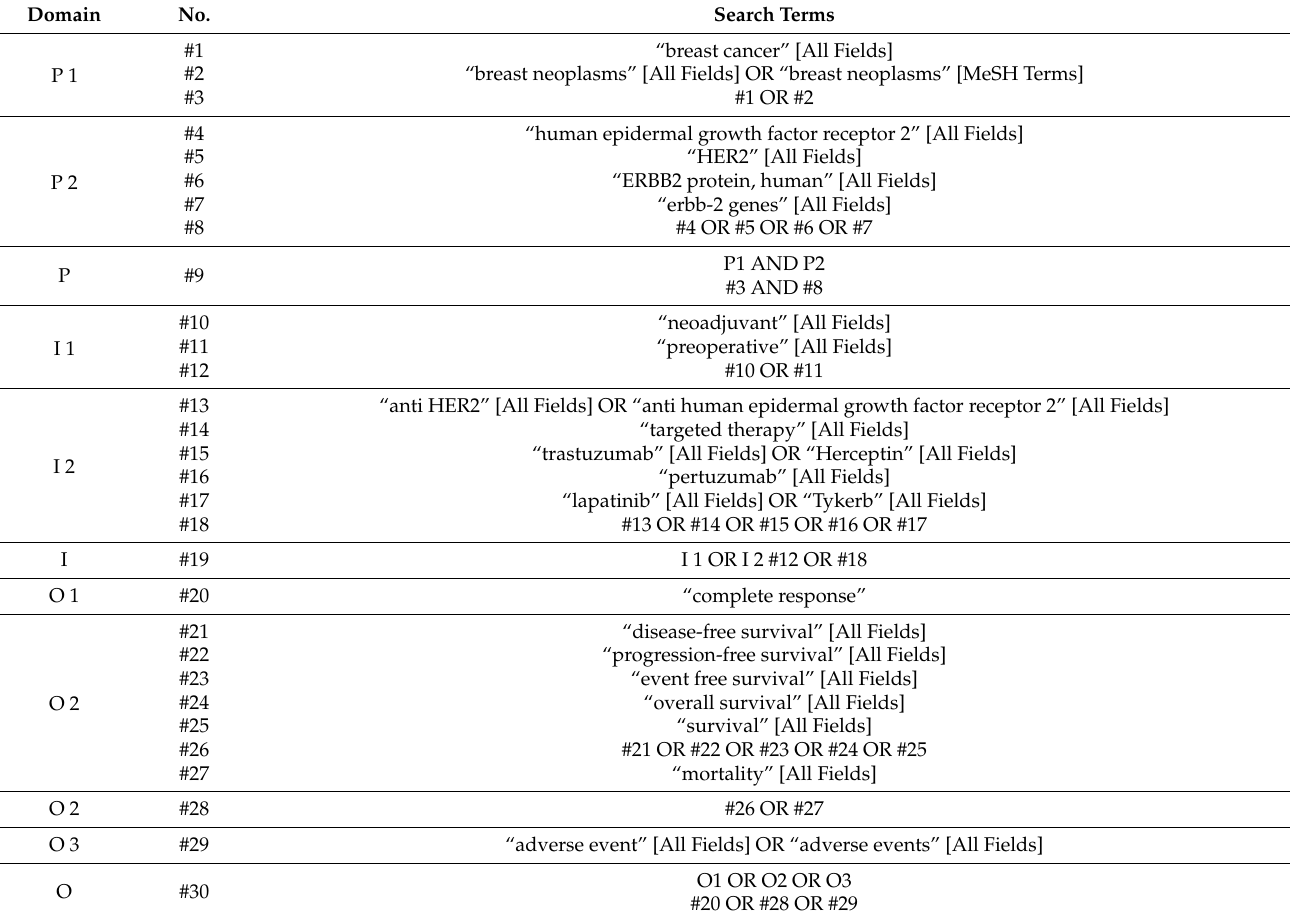
Table A1. Search terms and search strategy in